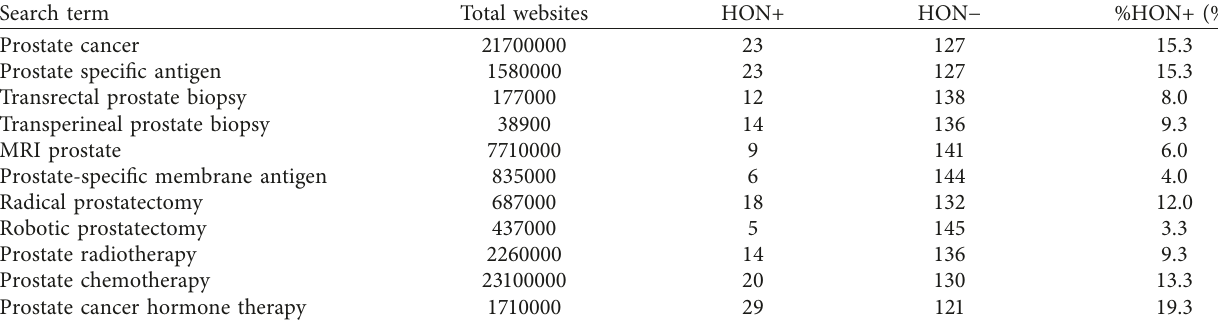
Table 1: Rates of HON-accredited websites among the search terms.